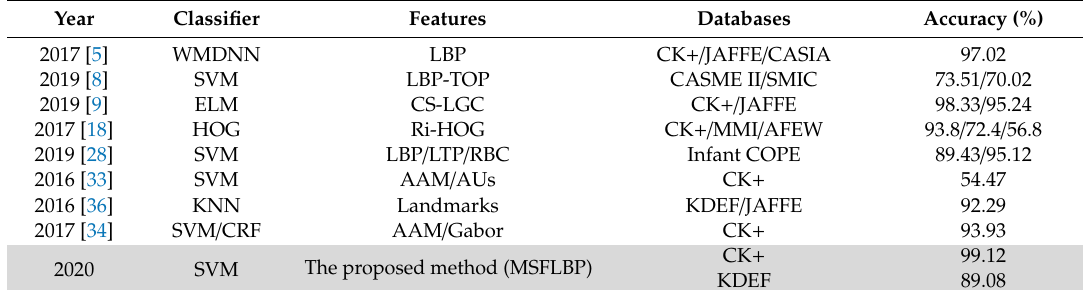
Table 6. Results of reviewed works for static image approaches (values are in